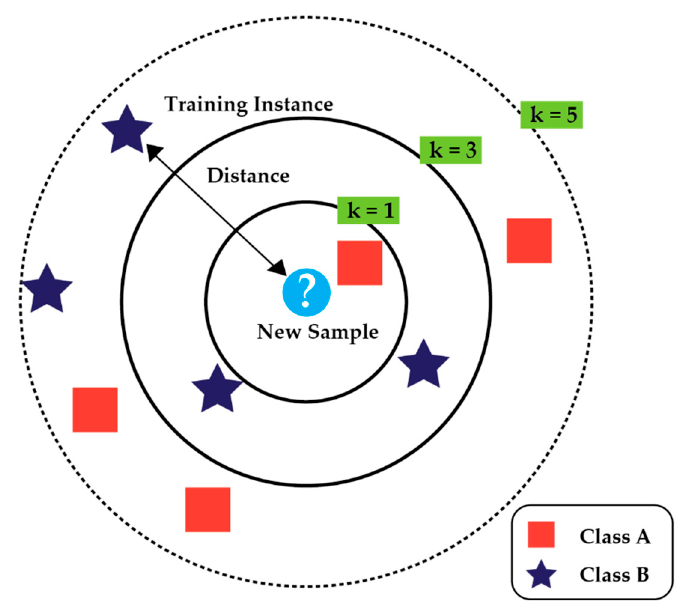
Figure 7. Illustration of the k-NN algorithm for a binary classification problem.